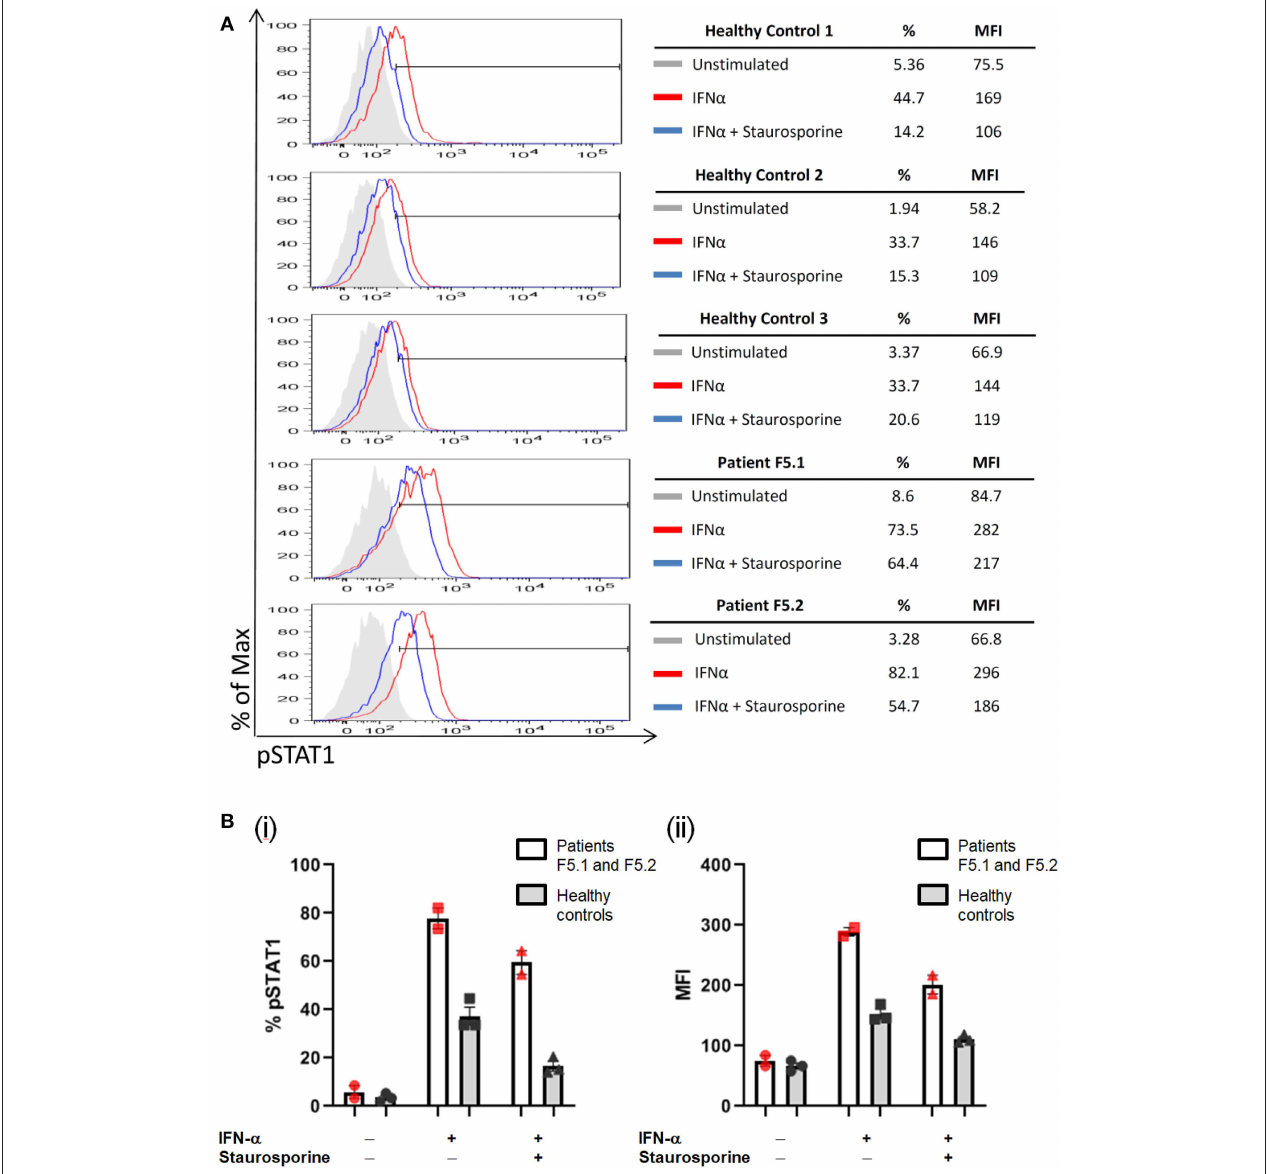
FIGURE 3 | PBMCs were stimulated with IFN- α (40,000 IU/ml) followed by treatment with staurosporine (500nM) for 30min, and analyzed for intracellular pSTAT1 expression by gating on CD3 + T-cells. The increase in %pSTAT1 + population in stimulated cells relative to unstimulated cells was calculated. (A) Representative histograms are shown for Patients F5.1 and F5.2 and 3 healthy controls. (B) %pSTAT1 + T-cells (i) and mean fluorescent intensity (MFI) (ii) in Patients F5.1 and F5.2 compared with 3 healthy controls. Data expressed as mean ±